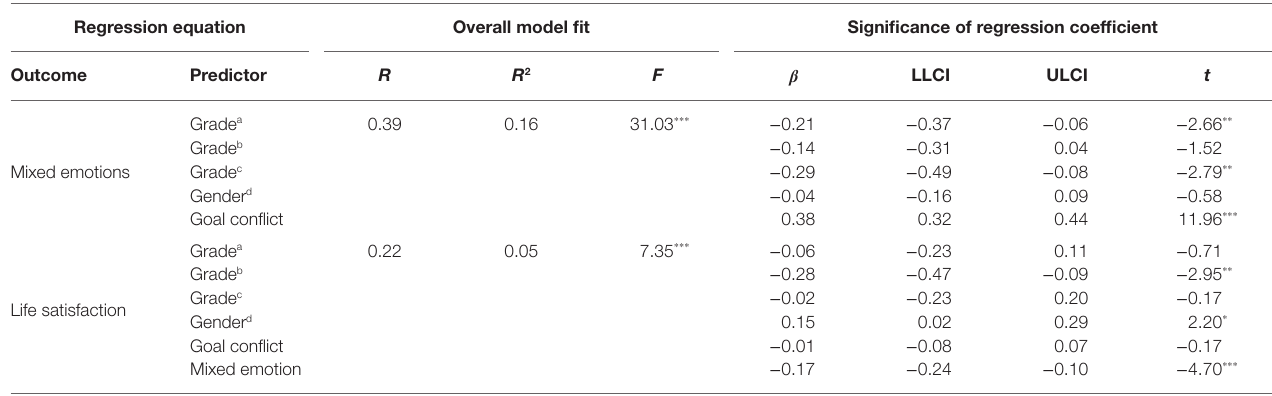
TABLE 2 | Regression analysis results of the mediating role of mixed emotions between goal confliction and life satisfaction. Regression equation Overall model